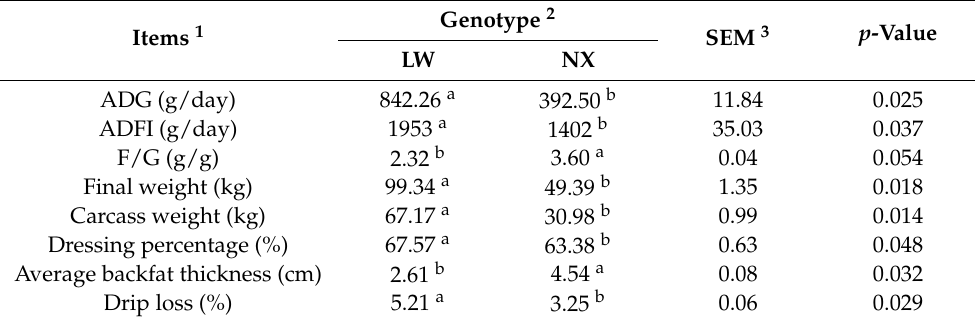
Table 1. Performances and carcass characteristics between Ningxiang pig and Large white